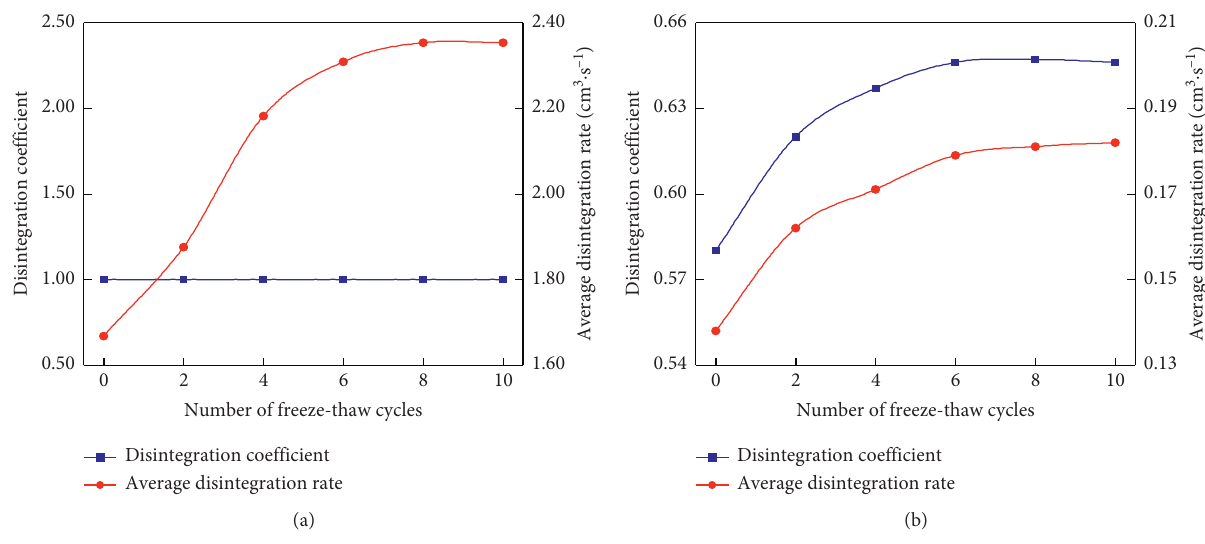
Figure 7: The effects of F-T cycles on disintegration with the number of cycles: (a) control loess; (b) fiber-reinforced